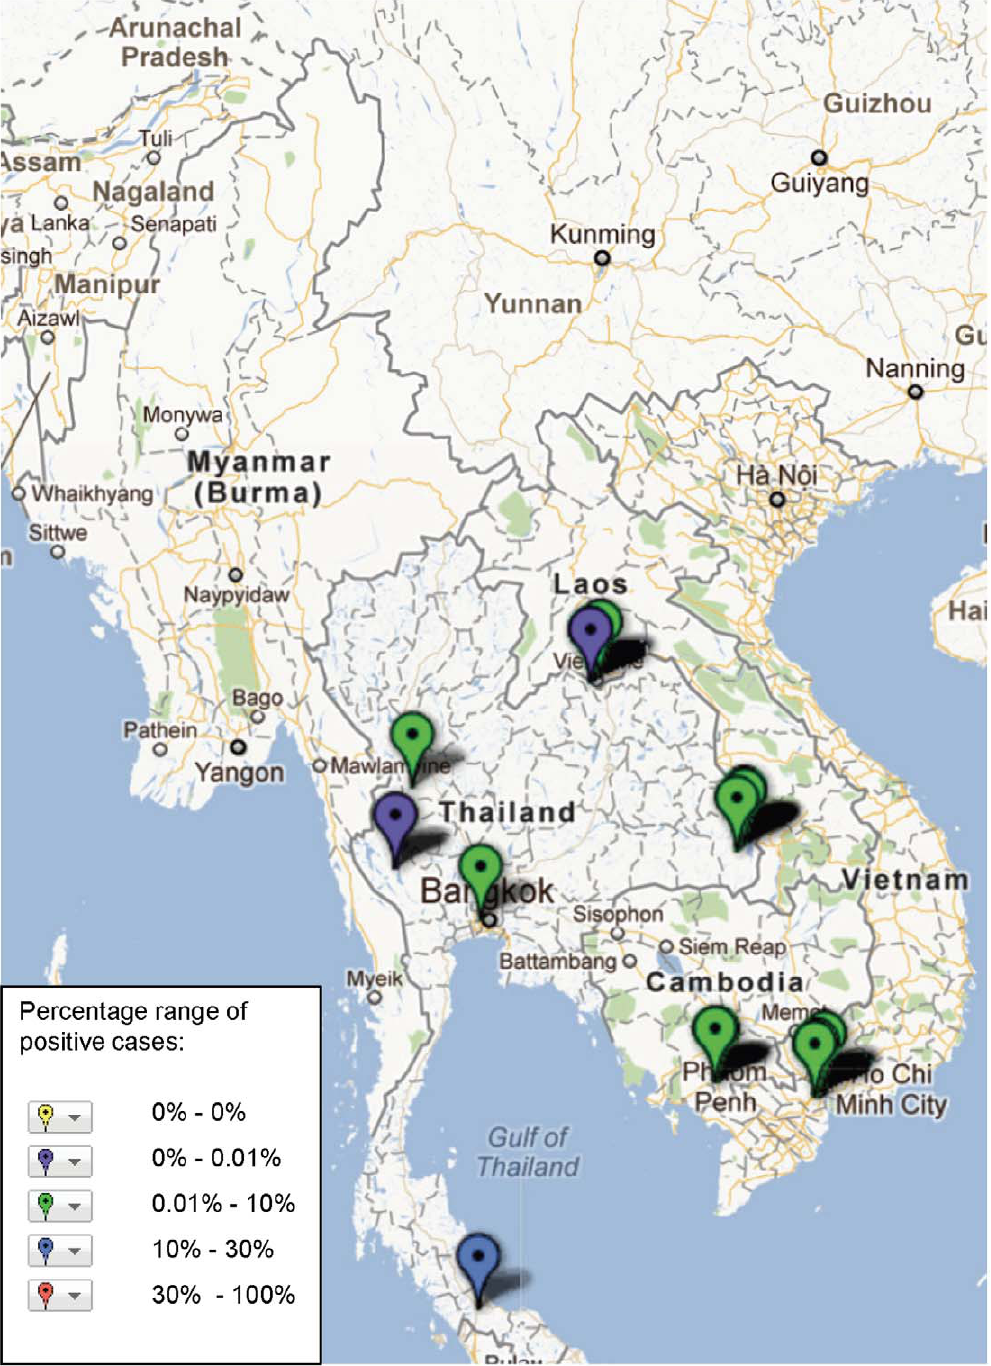
Figure 10. Study sites in the Mekong region where other bacteria (e.g. E.coli and Pseudomonas , Streptococcus , Staphylococcus , Shigella , Klebsiella , Haemophilus species) have been reported, illustrating frequency of identification (case) based on assays and sample population used in the study (see Table S1).